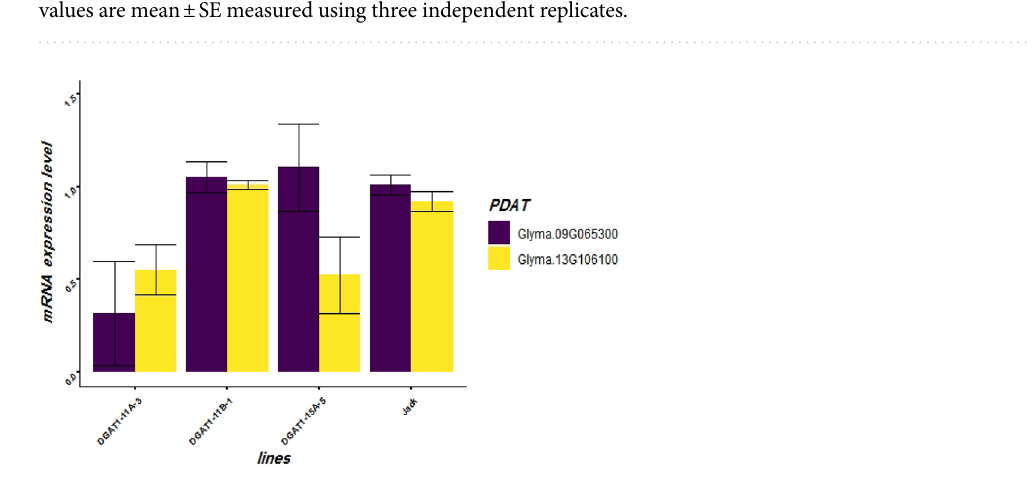
Figure 9. The qPCR analyses of relative expression level of two phospholipid: diacylglycerol acyltransferase ( PDAT ) isoforms in transgenic lines DGAT1-11A-3, DGAT1-11B-1, DGAT1-15A-5 and Jack at T 2